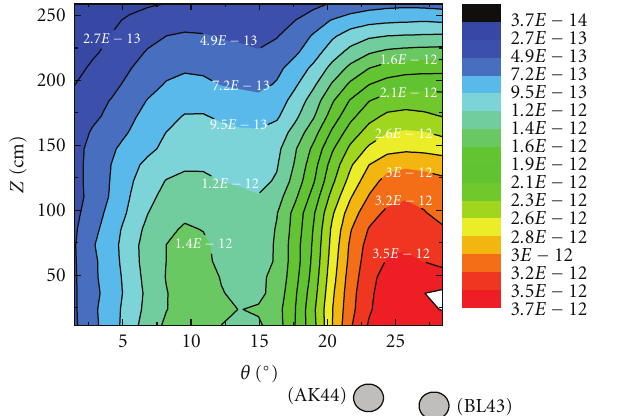
Figure 8: Rate of DPA in terms of Z and Theta on the inner surface of the RPV (369.5cm).